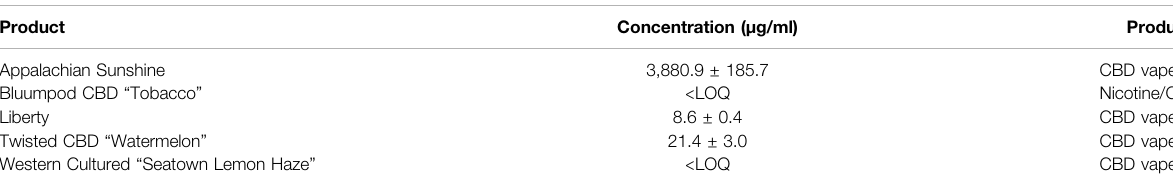
TABLE 6 | Olivetol concentrations in e-liquids.